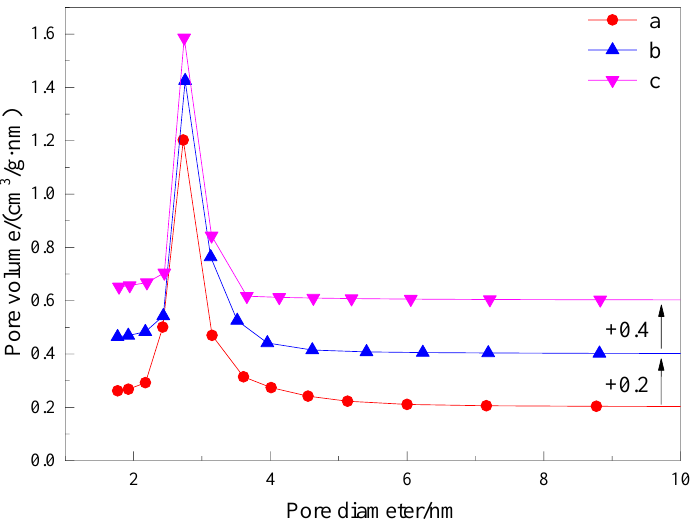
Figure 7. N 2 adsorption – desorption isotherms of the samples. a -Mesoporous material synthesized with Gemini ionic liquid surfactant [N 1116 C 3 IMC 16 ][Br] 2 as template. b -Mesoporous material syn- larger than that of other materials, which gives the material synthesized by asymmetric thesized with Gemini ionic liquid surfactant [N 1116 C 3 N 1116 ][Br] 2 as template. c -Mesoporous material ionic liquid more suitable structural characteristics for dye adsorption than the other two. synthesized with Gemini ionic liquid surfactant [C 16 IMC 3 C 16 IM][Br] 2 as template.